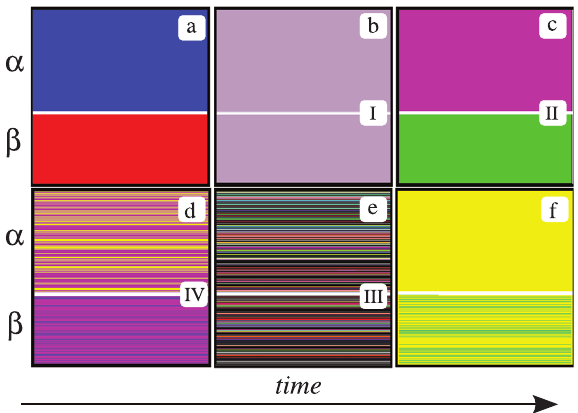
Figure 3. Each panel displays an asymptotic state (vertical axis) of the agents in the interacting populations a (upper part) and b (lower part) vs. time (horizontal axis), corresponding to a Figure 2. S 1 , S 2 , and P 1 ( M b ) as functions of q , with F ~ 10 , for a a a different phase in the system. Each value of the state variable of an different values of B . System size is N ~ 800 with partition N a ~ 0 : 6 N . agent is represented by a different color. Population sizes are Each data point is the result of averaging over 100 random realizations N (open circles), S 1 (solid circles); with B ~ 0 . (b) of initial conditions. (a) S 1 a b (open circles); right vertical axis: P 1 Left vertical axis: S 1 ( M b ) (crosses); a a fixed B ~ 0 : 001 . Phases I and II. (c) Left vertical axis: S 1 (open circles), S 2 a a